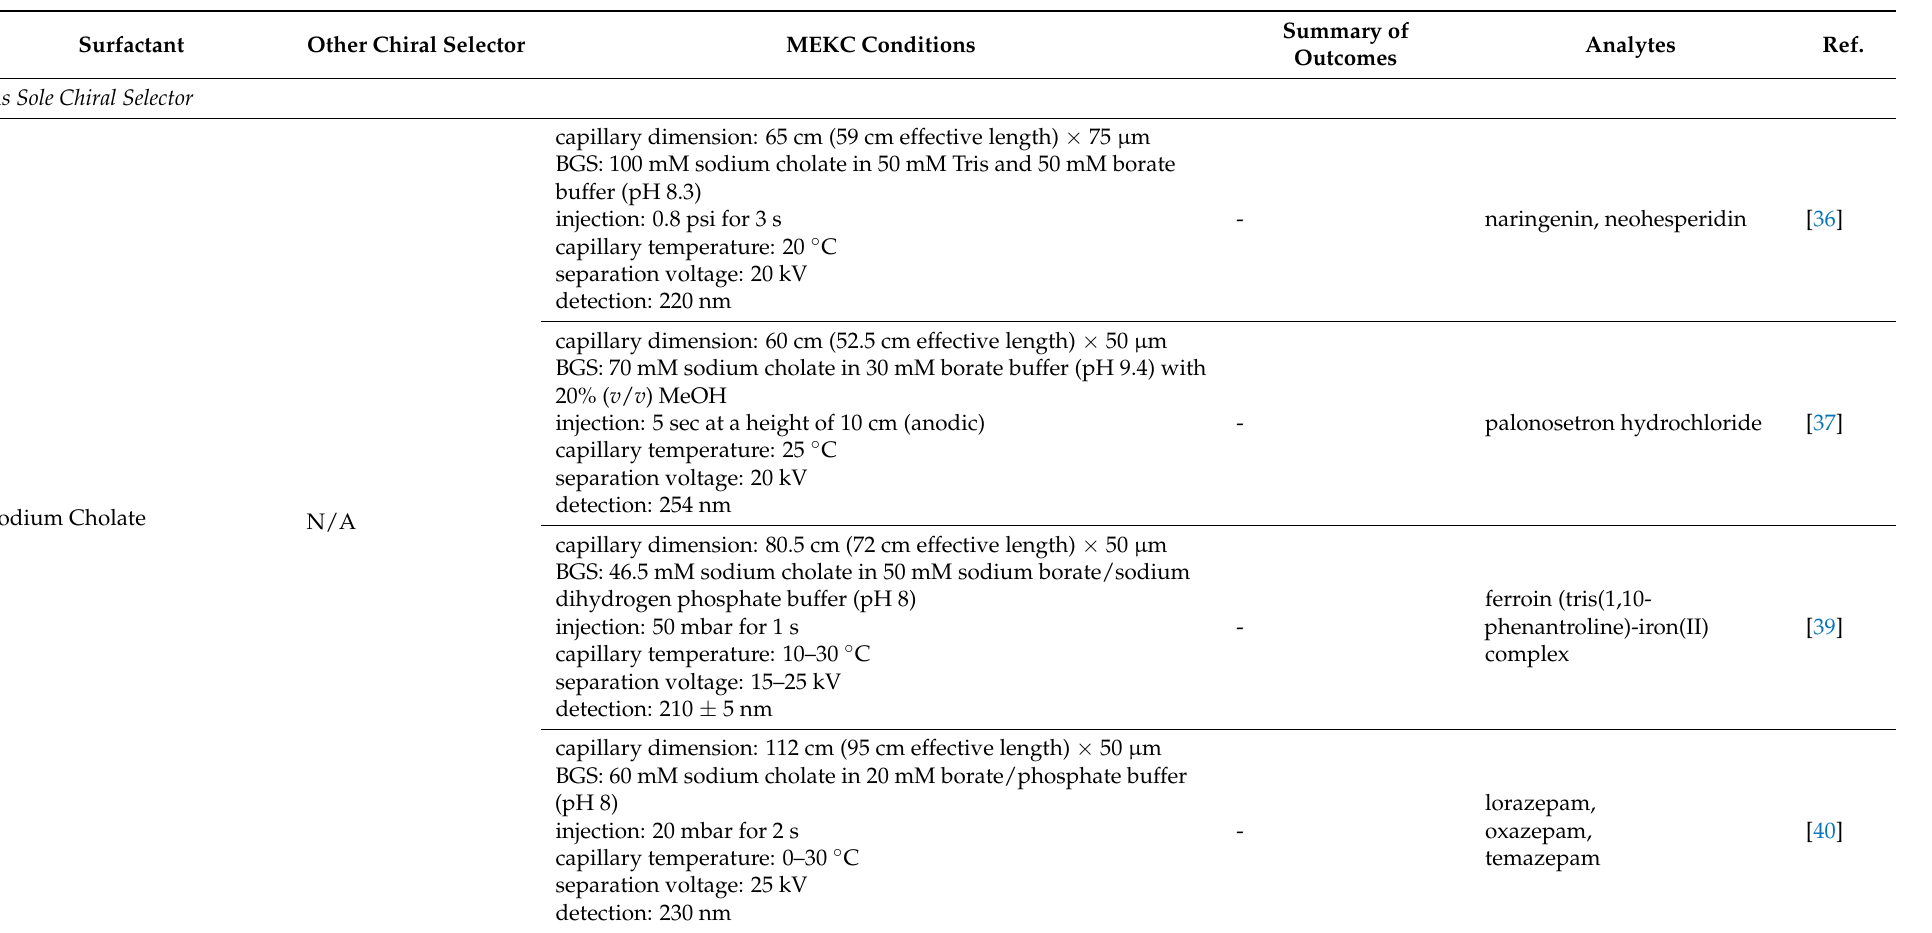
Table 2. Chiral surfactants used in MEKC, other CS involved, conditions used, summary of outcomes, analytes tested and their corresponding references.